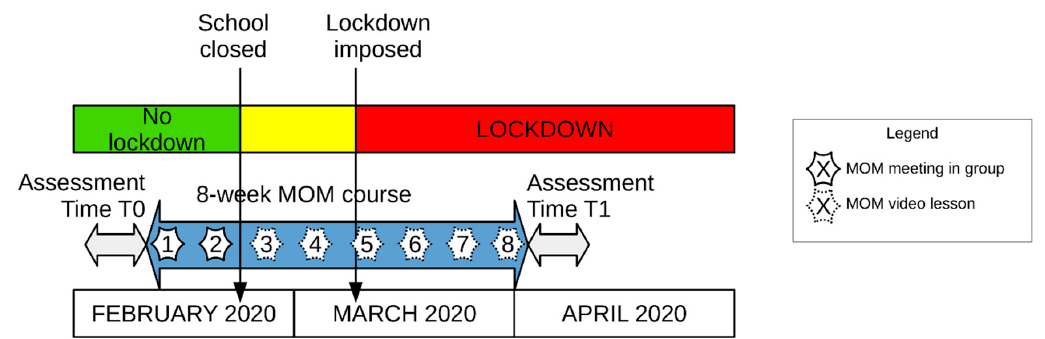
Figure 1. Timeline of Mindfulness-Oriented Meditation (MOM) training delivered to a group of Italian school teachers during the Covid-19 health emergency. The MOM training started with group meetings and continued with individual lessons via the